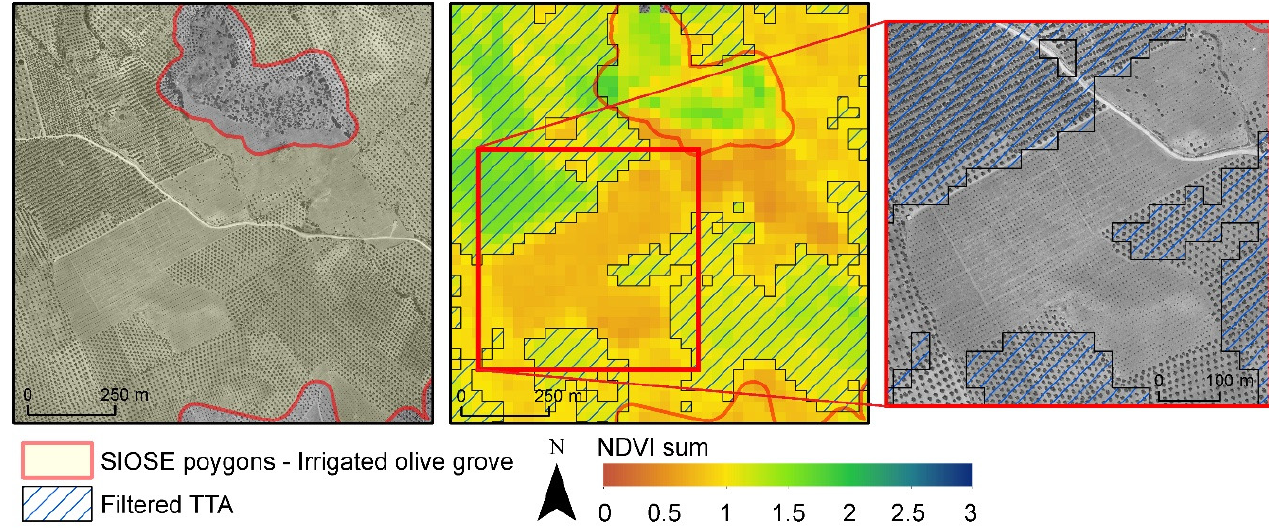
Figure 13. Rule 3 applied to irrigated olive grove polygons. Brown NDVI colours depict more recent plantations or low-density plantation schemes. The red square zoom details new plantation fields. The white line in the zoom is a road.